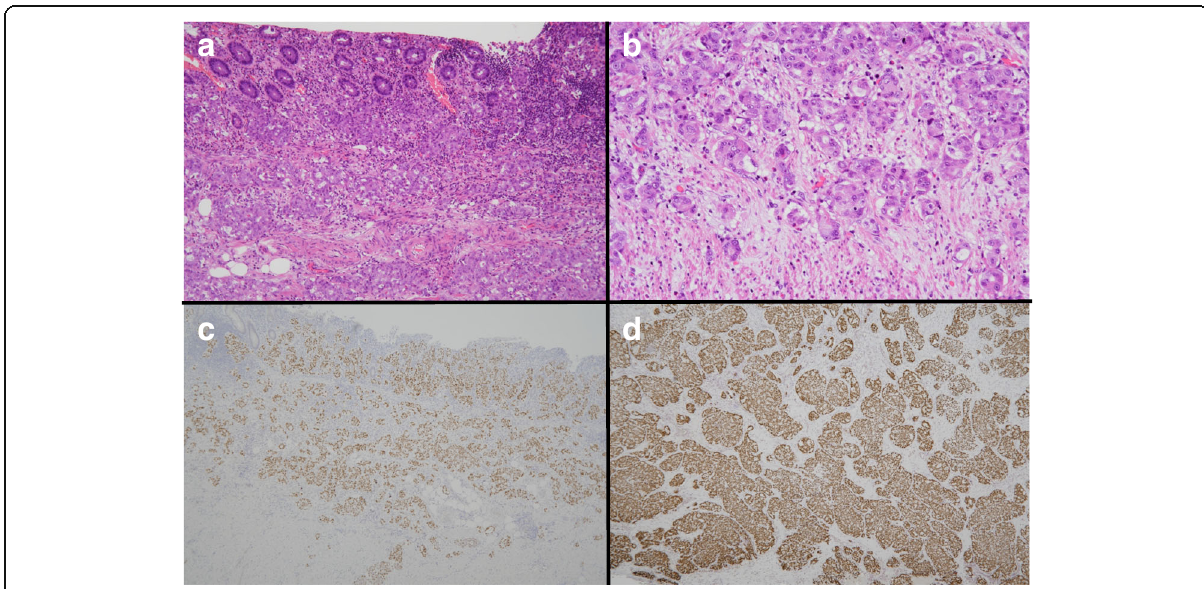
Fig. 4 Pathological findings. The findings of hematoxylin and eosin staining are shown in a low-power field and b high-power field. Adenocarcinoma infiltrated the mucosal, submucosal, and muscular layers. Immunopathological findings of TTF-1 staining for the c appendix and d cervical lymph node are shown. The adenocarcinoma in the appendix and cervical lymph node showed positive staining for